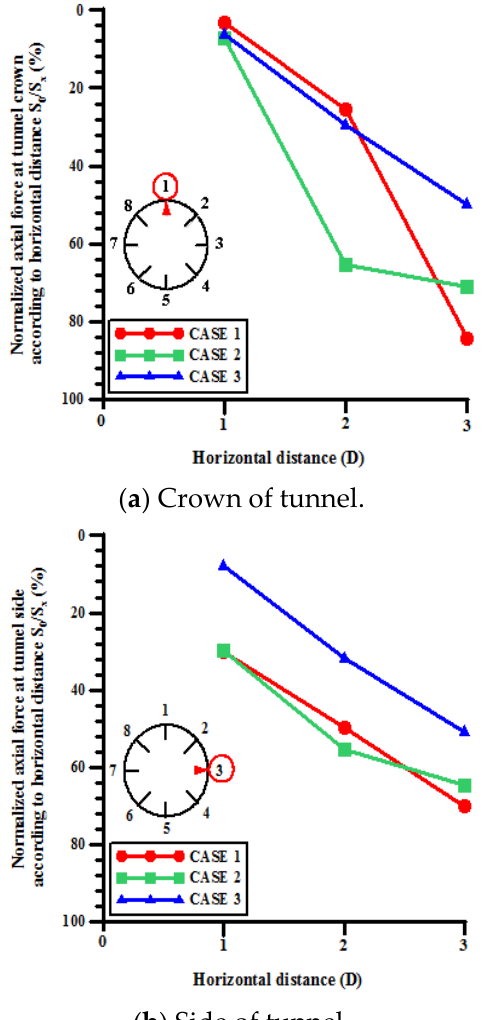
Figure 26. Normalized axial force by ultimate load according to horizontal offset (3D numerical analysis).